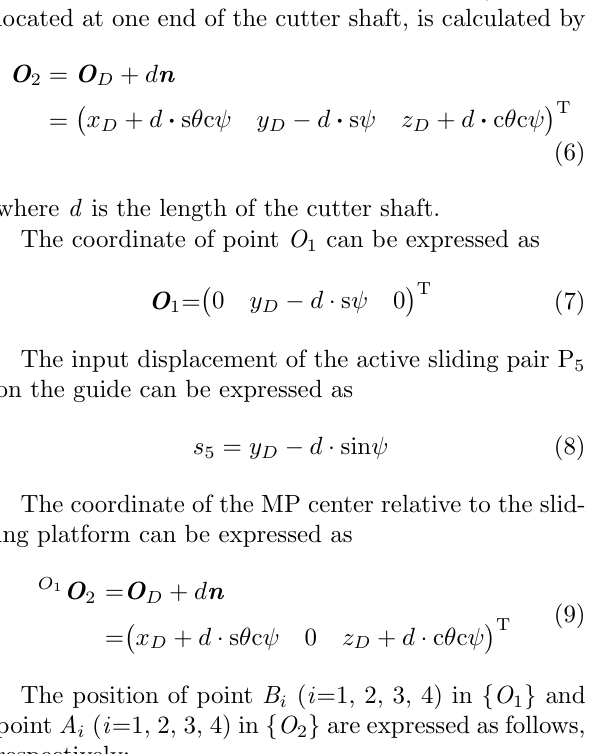
Figure 4: The extreme position of the MP along x axis positive direction